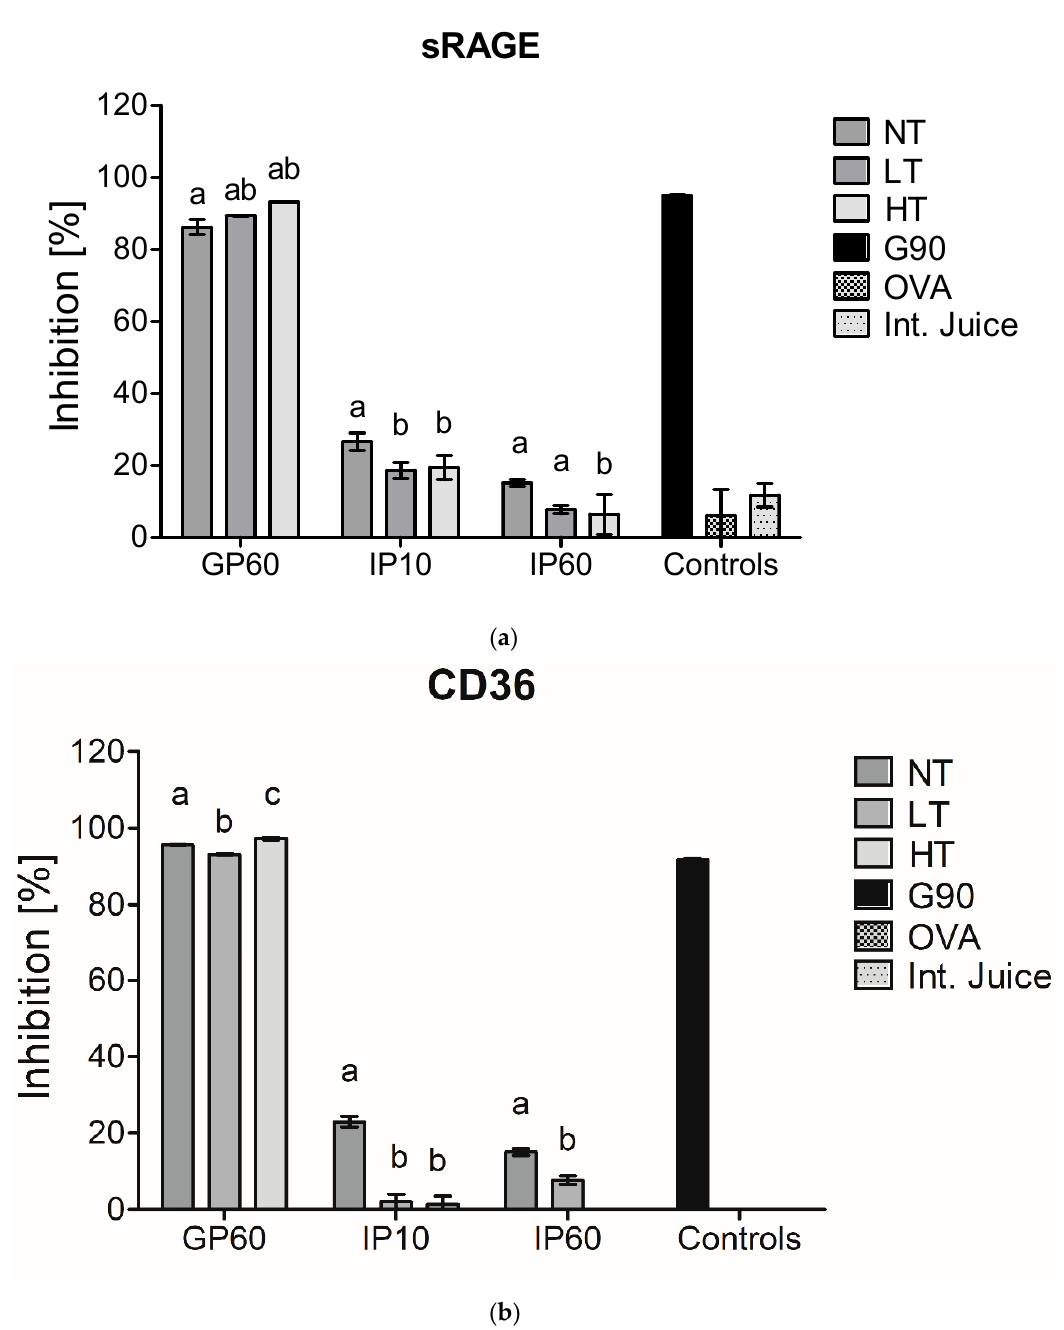
Figure 4. sRAGE inhibition ELISA ( a ) and CD36 inhibition ELISA ( b ) of simulated infant in vitro digests of 200 µg/mL milk protein, non-treated (NT), heated at low temperature (LT), heated at high temperature (HT), and the intestinal juice (Int. Juice). Soy protein, glycated with glucose for 90 min at 100 °C (G90), was used as a positive control, while ovalbumin (OVA) was used as negative control. Statistical differences within the same digestion time point were determined using one-way ANOVA. Values are considered as statistically different at p < 0.05, with different letters indicating statistically significant differences between samples.